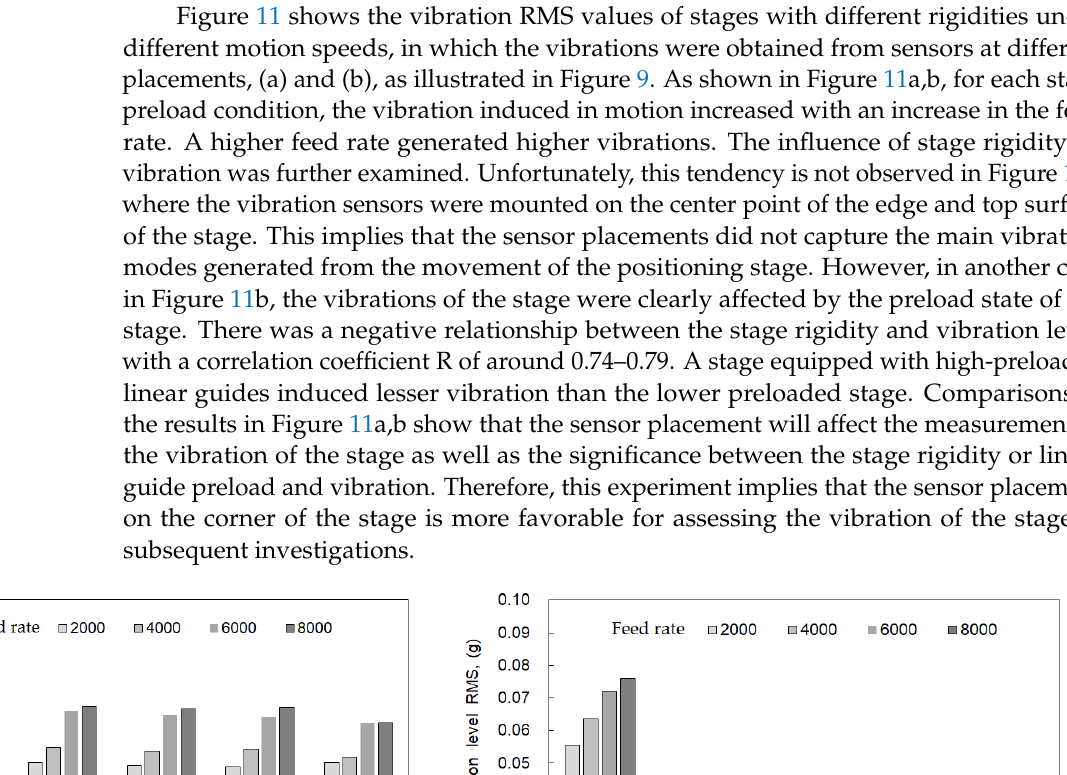
Figure 12. Schematic of dynamic model and angular motion of stage: ( a ) dynamic model of stage [41] and; ( b ) derivation of angular acceleration [42].